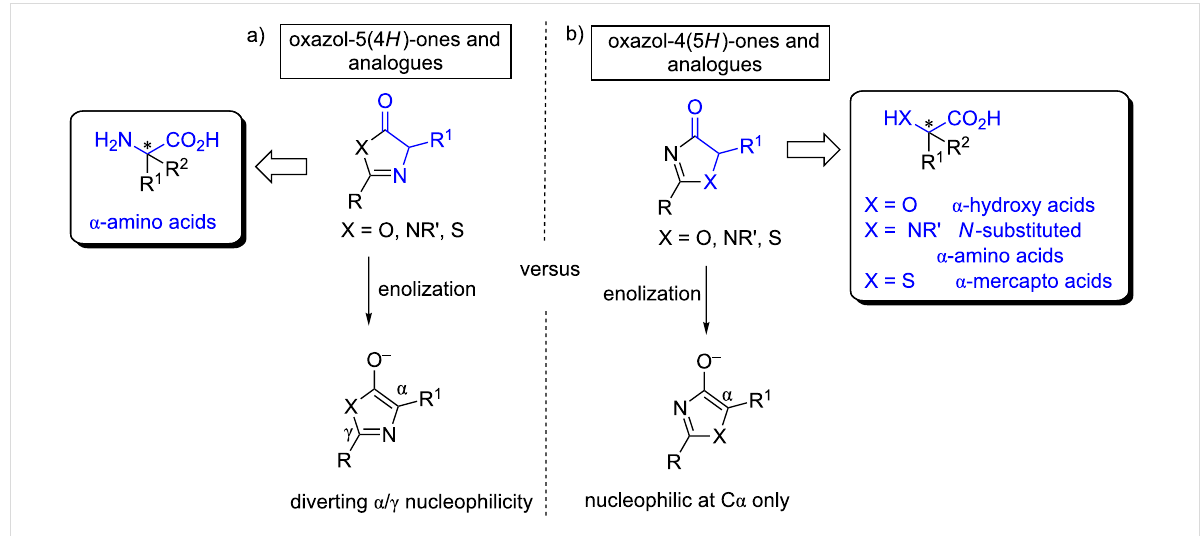
enolate or equivalent is fixed due to their cyclic nature, thus facilitating the control of the stereoselectivity; iii) they are substituted at the α -position of the carbonyl and therefore, after reaction with an electrophile, a tetrasubstituted stereocenter is created and, iv) the resulting adducts can be easily hydrolyzed to provide carboxylic acids or their derivatives carrying differ- ent functionalities.